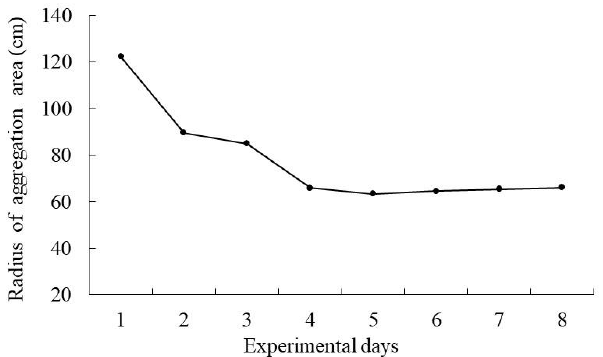
Figure 7. Changes in the radius of the aggregation area of the juvenile Pagrus major trained with 400 Hz square-wave continuous tones from the 1st day to the 8th day.